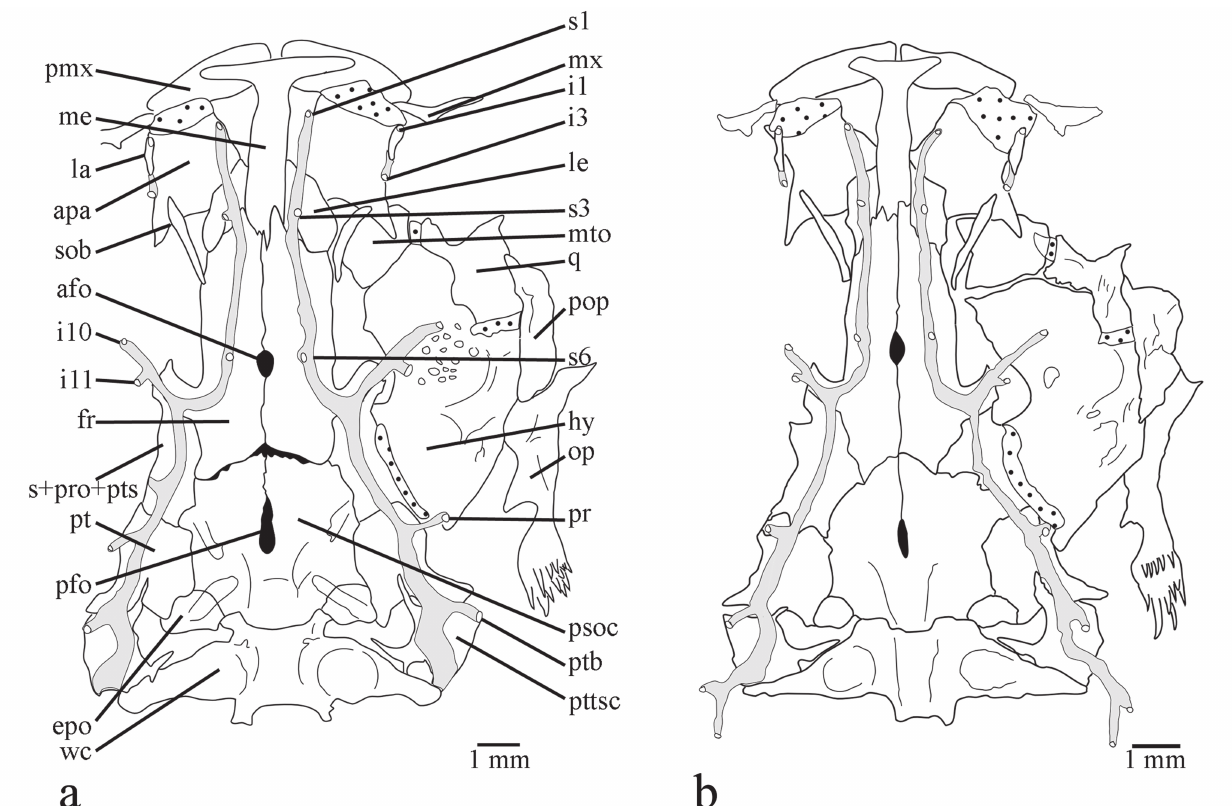
Fig. 2. Neurocranium, Weberian complex, and right suspensorium and opercular series of: a. Trichomycterus steindachneri (MBUCV-V-35652), paratype, 86.7 mm SL. b. T. cachiraensis (MBUCV-V-35384), paratype, 74.9 mm SL. Dorsal view. Abbreviations: afo, anterior fontanel; apa, autopalatine; epo, epioccipital; fr, frontal; la, lachrymal-antorbital; le, lateral ethmoid; hy, hyomandibula; i1, infraorbital sensory pore 1; i3, infraorbital sensory pore 3; i10-11, infraorbital sensory pores 10 and 11; me, mesethmoid; mto, metapterygoid; mx, maxilla; op, opercle; pfo, posterior fontanel; pmx, premaxilla; pop, preopercle; pr, preopercular sensory pore; psoc, parieto-supraoccipital; pt, pterotic; ptb, pterotic branch; pttsc, posttemporo-supracleithrum; q, quadrate; s1, supraorbital sensory pore 1; s3, supraorbital sensory pore 3; s6, supraorbital sensory pore 6 (epiphyseal branch); sob, sesamoid supraorbital; sp+pro+pts, sphenotic-prootic-pterosphenoid complex bone; wc, Weberian